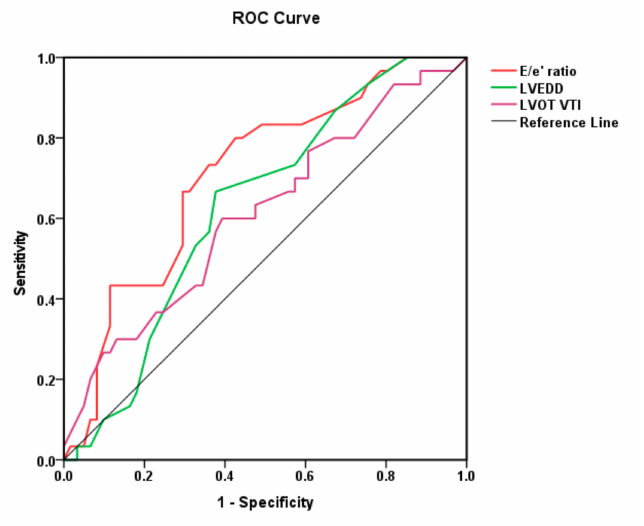
Figure 2. The ROC curve for each of the three independent determinants (LVEDD—green, E/e’ ratio—red, LVOT VTI—purple) for HFR at 6 months. AUC are as follows: E/E’ ratio = 0.710 ( p = 0.001), LVEDD = 0.630 ( p = 0.045), LVOTVTI = 0.611 ( p = 0.085).